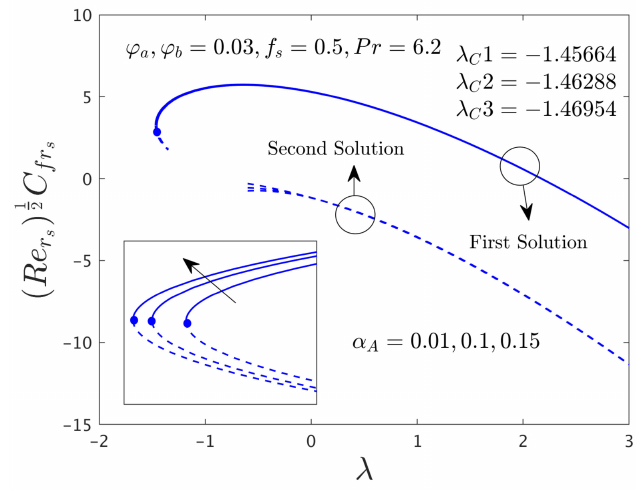
C fr against λ for numerous choices of α A s s